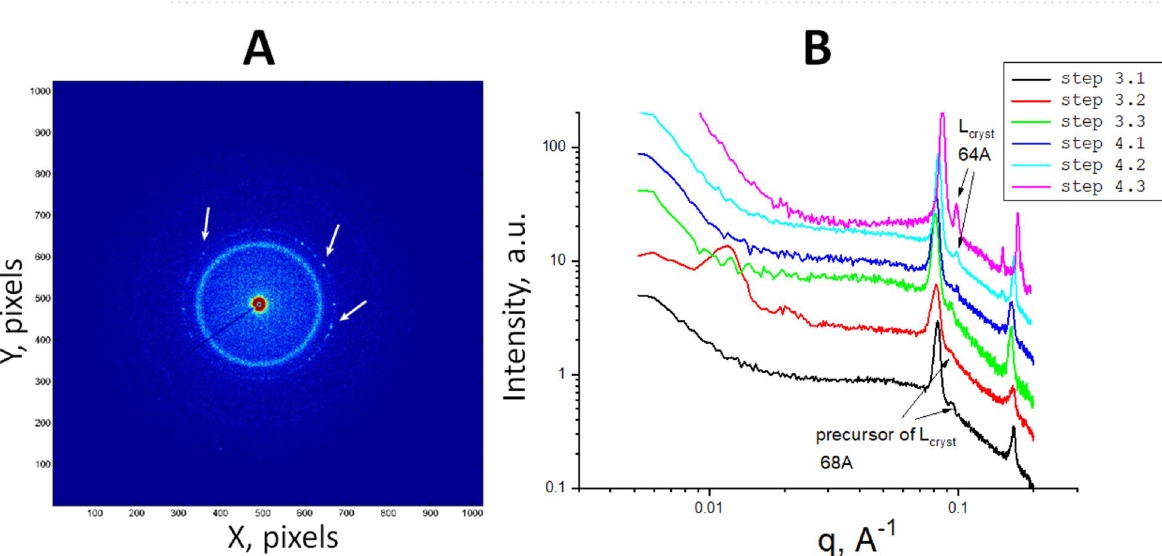
Figure 6. Behavior of the peak for the local lamellar phase L cryst . ( A ) 2D pattern for the sample containing the BR crystals (corresponds to 1D curve step 4.3 in Fig. 3). The reflections corresponding to the local lamellar phase L cryst are shown by white arrows. The scattering ring belongs to the multilamellar phase Lα with a spacing of about 84 Å. ( B ) Behavior of the peak for the local lamellar phase L cryst on the 1D curves. All the SAXS curves belong to different time points of the same sample. The crystallization conditions are the same as for the sample in Fig.